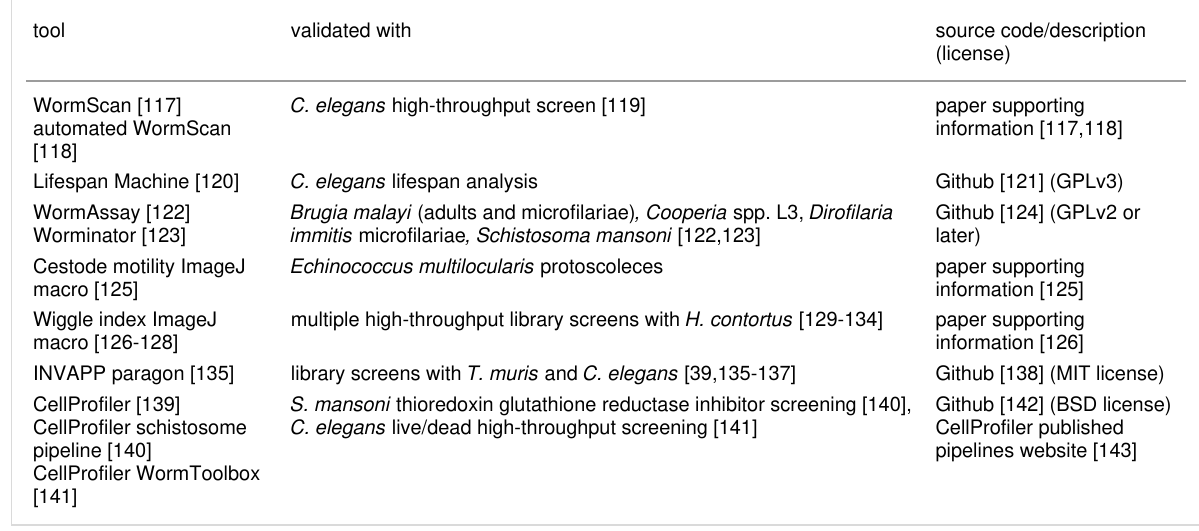
Table 3: Open tools for high-throughput phenotypic screening of motility and viability and their use for anthelmintic discovery.